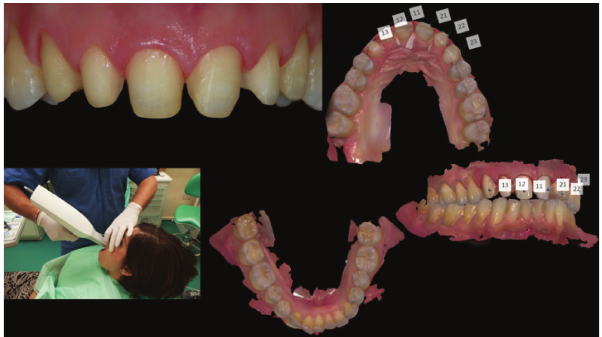
Figure 4: Case 1 (MonolithicLithiumDisilicate Onlays). Theonlays after adhesive cementation.